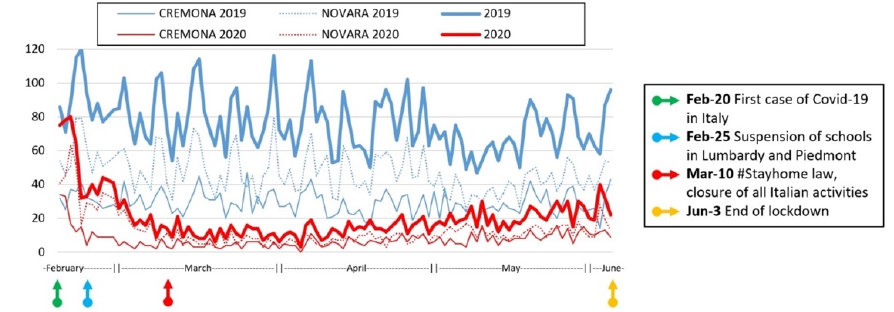
Figure 1. Admissions to pediatric EDs during the COVID-19 pandemic between 20 February 2020 and 2 June 2020 compared with the same period in 2019.